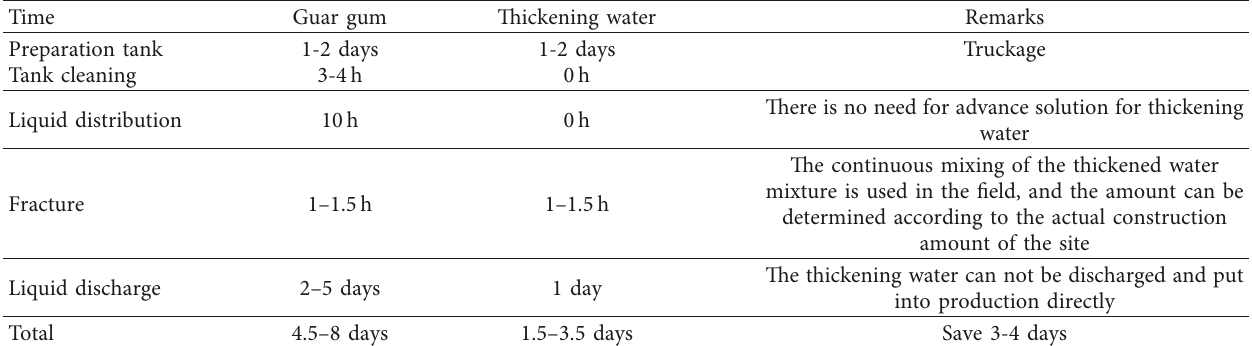
Table 6: Comparison of operation